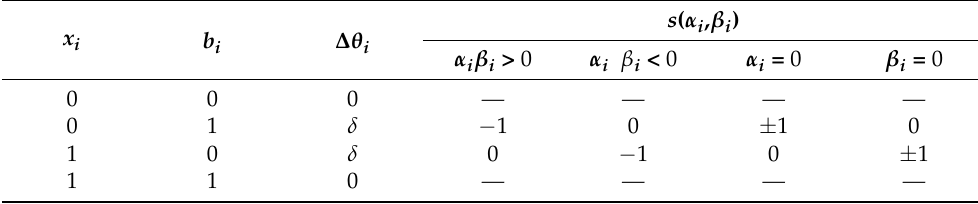
Table 1. Rotation angle selection strategy.